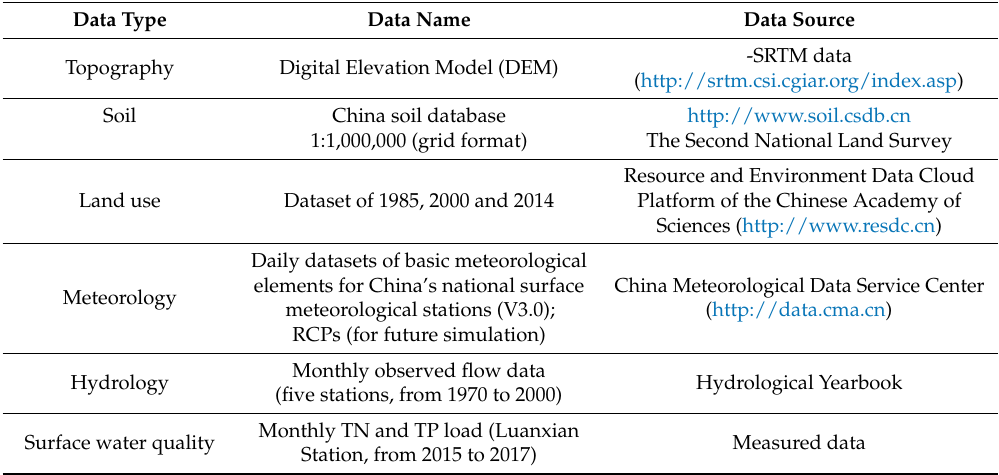
Table 1. Input data types and main